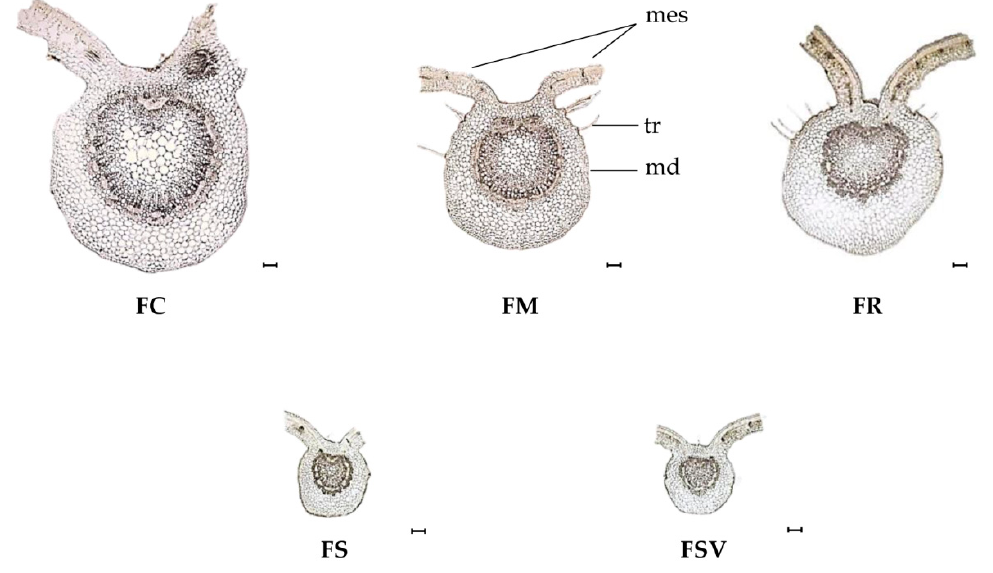
Figure 3. Transverse section of the midrib of leaves from four Fraxinus species and one variety ( × 40). Black bars mean 100 µ m; mes , mesophyll; md , midrib; tr , trichome; FC, Fraxinus chiisanensis ; FM, F. mandshurica ; FR, F. rhynchophylla ; FS, F. sieboldiana ; FSV, F. sieboldiana var. angustata . Table 3. Anatomical characteristics of the midrib of Fraxinus